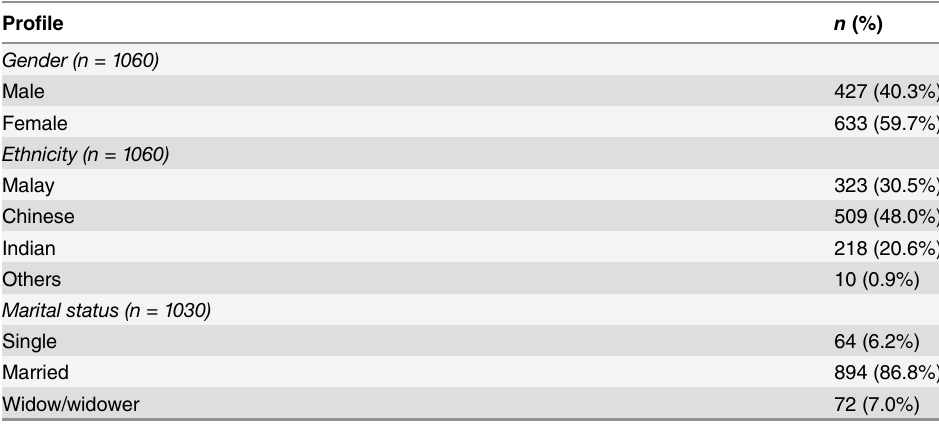
Table 1. Patients sociodemographic profile.